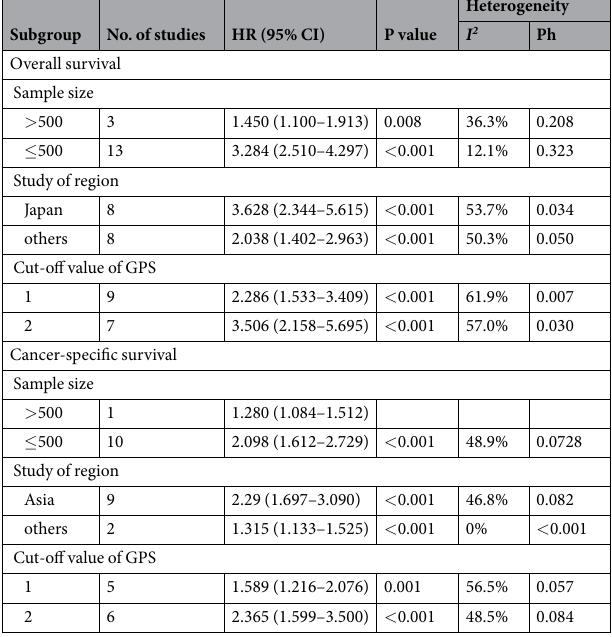
Table 2. Results of subgroup analysis.